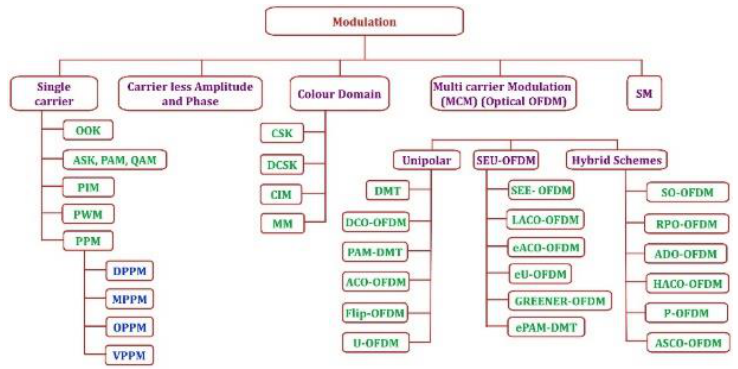
Figure 38. Various modulation techniques being used in WOC.